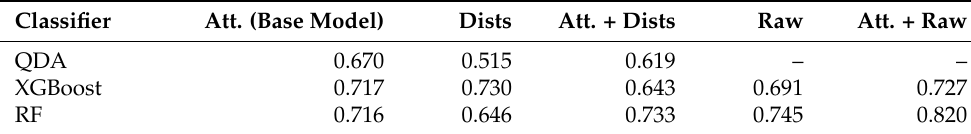
Table 4. Macro F1 scores of the different classifiers and feature subsets.